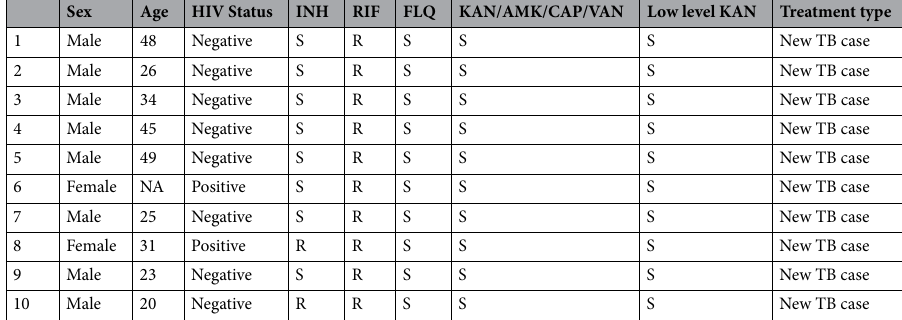
Table 1. Patient demography and rapid diagnostic molecular drug resistance outcome. NA not available, S sensitive, R resistant, FLQ fluoroquinolones, KAN kanamycin, AMK amikacin, CAP capreomycin, VAN